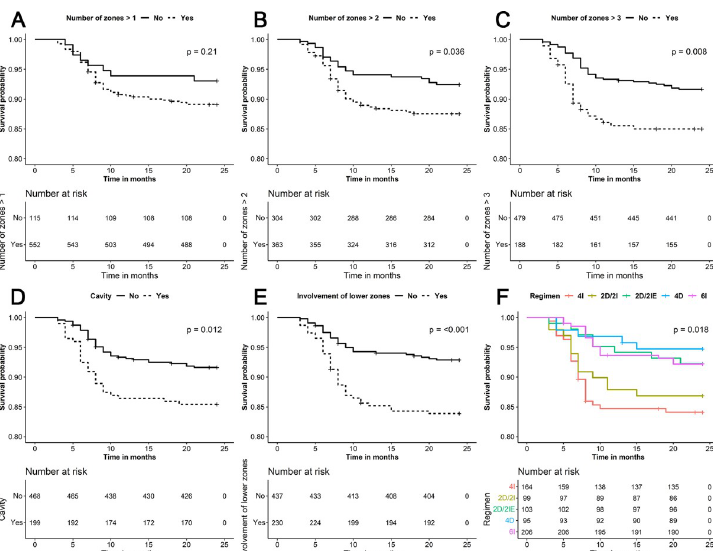
Fig 2. Kaplan-Meier Mean Survival Estimates for “Time to an Unfavourable Event” graphs A, B and C denote increasing order of zonal involvement, graph D—cavity present and absent, graph E—involvement of lower zones and graph F—regimen-wise distribution of unfavourable responses. > —Greater than, < —Lesser than, p–calculated probability. There was a significant difference in survival probability when the number of zones exceeded 2, there was presence of cavity or lower zone involvement and between regimens by the Log Rank (Mantel-Cox) test. The numbers given within parentheses reflects the number of individuals at risk for that factor studied, available at that particular time